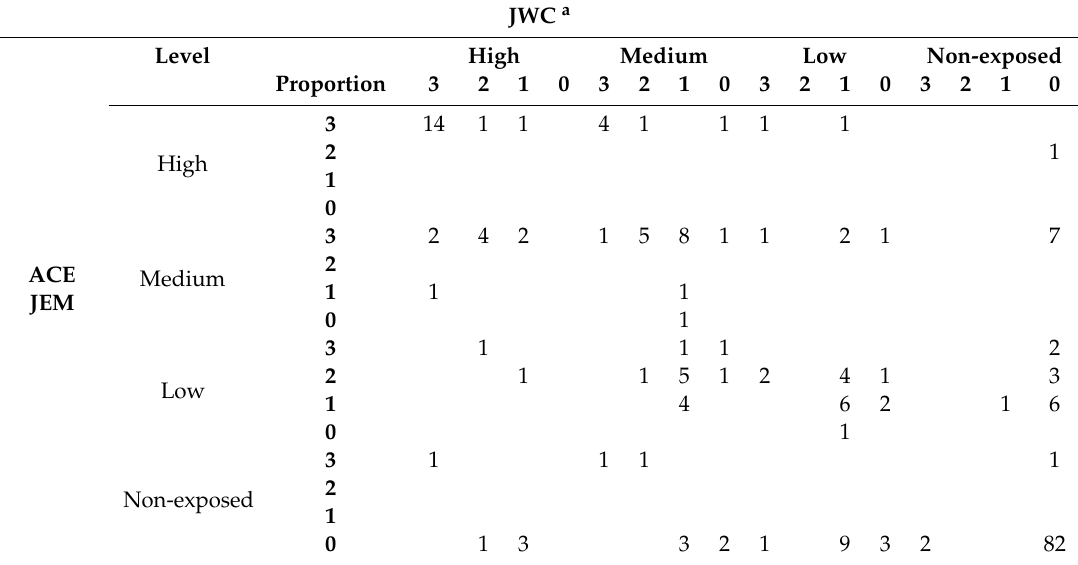
Table 8. Classification from the two assessments for level of exposure and proportions